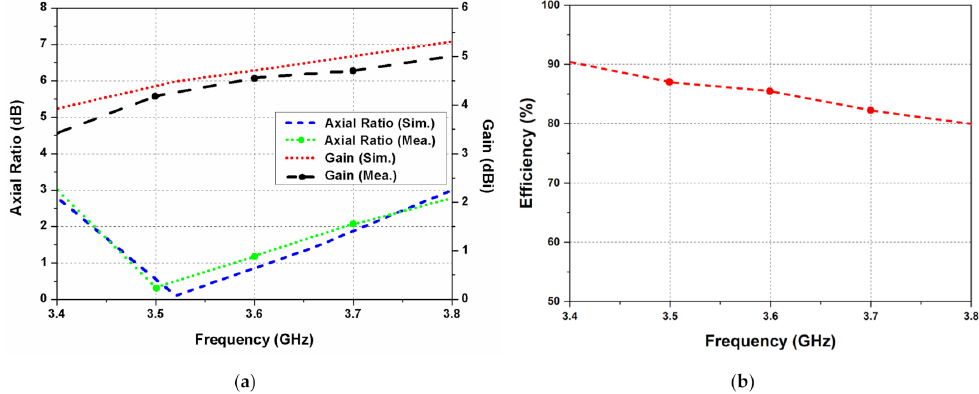
Figure 10. ( a ) Axial ratio and gain of the dual CP MIMO antenna; ( b ) radiation efficiency of the proposed antenna.